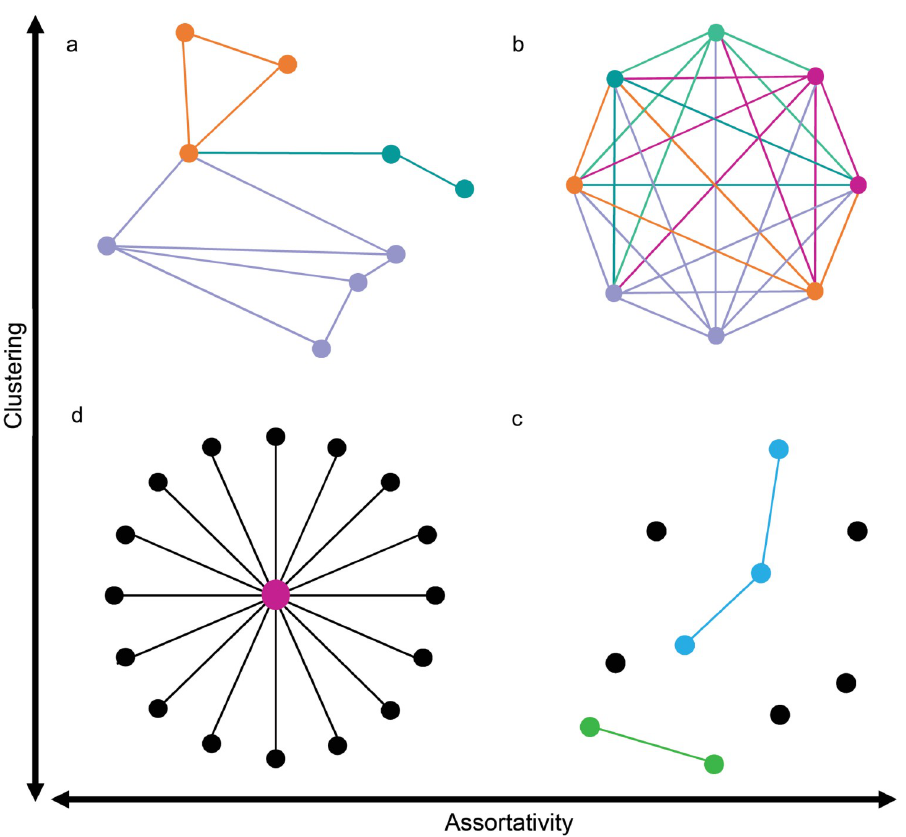
Fig 3. Idealised graph typology to explain network structures. a–polycephalous, b–clique-like, c–segmented- decentralised, d–star-like.